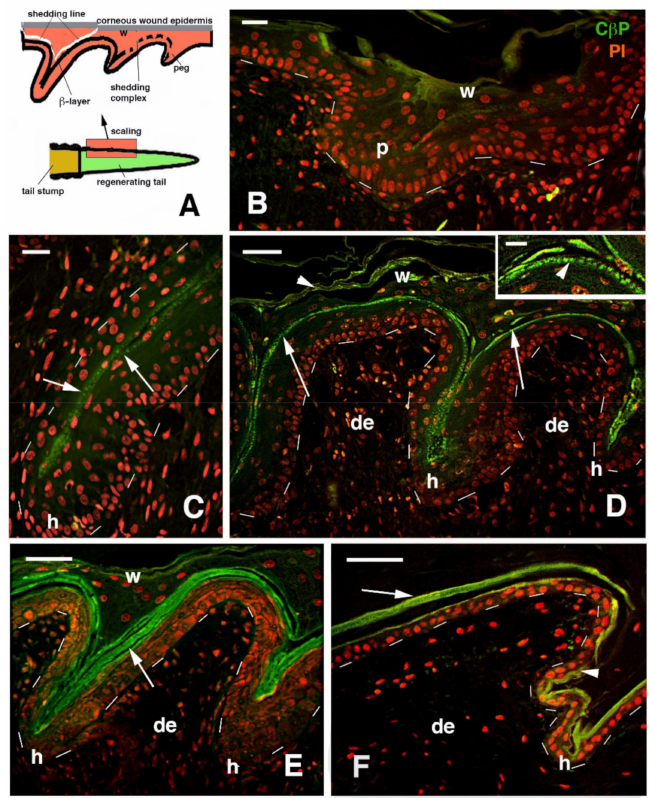
Figure 5. Drawing ( A ) and immunofluorescence for corneous beta proteins (C β P, green) and nuclear fluorescence from propidium bromide (red) in regenerating scales of P. muralis ( B – F ). ( A ) Drawing illustrating the proximal–distal formation of scales and the detachment of the external corneous wound epidermis along the shedding line, producing a molt. ( B ) Initial formation of epidermal pegs in the distal epidermis of a regenerating tail. Bar, 10 µ m. ( C ) Detail showing the initial formation of the clear oberhautchen layer in the middle (arrows) of an elongated peg. Bar, 10 µ m. ( D ) Formation of 2 scales separated by a hinge region that evidences a weakly immunolabeled outer corneous layer of the wound epidermis (arrowheads) and, more intensely, the forming oberhautchen layer (see detail in the inset, bar, 5 µ m). Bar, 20 µ m. ( E ) Intense labeling (arrows) of the thick beta layer in regenerating scales that are at a more advanced stage of morphogenesis than the previous figure. Bar, 20 µ m. ( F ) Regenerated scale after shedding of the wound epidermis, see ( A ), with a compacted and immunolabeled beta-layer (arrow) that also extends to the oberhautchen (arrowhead) present in the inner and hinge regions of the new scale. Bar, 20 µ m. Legends: de, dermis p, peg; h, forming hinge regions (inter-scale); w, corneous layer of the wound epidermis. Dashes underline the